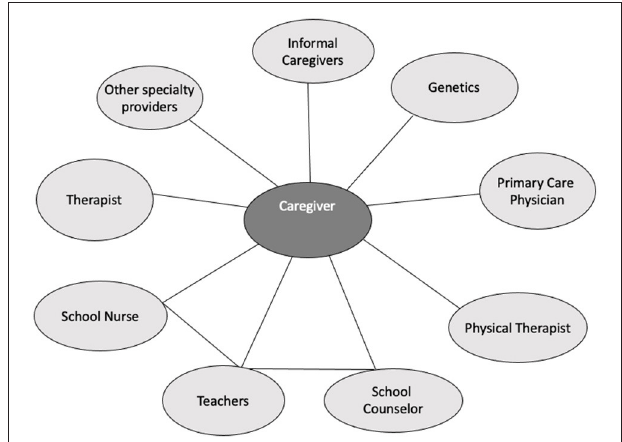
FIGURE 2 | Network map of providers involved in caring for a pediatric patient with hypermobile Ehlers-Danios Syndrome (hEDS). The network map displays providers involved in the management of Hypermobile Ehlers-Danlos Syndrome (hEDS), including the informal caregiver. Source: Gittell (